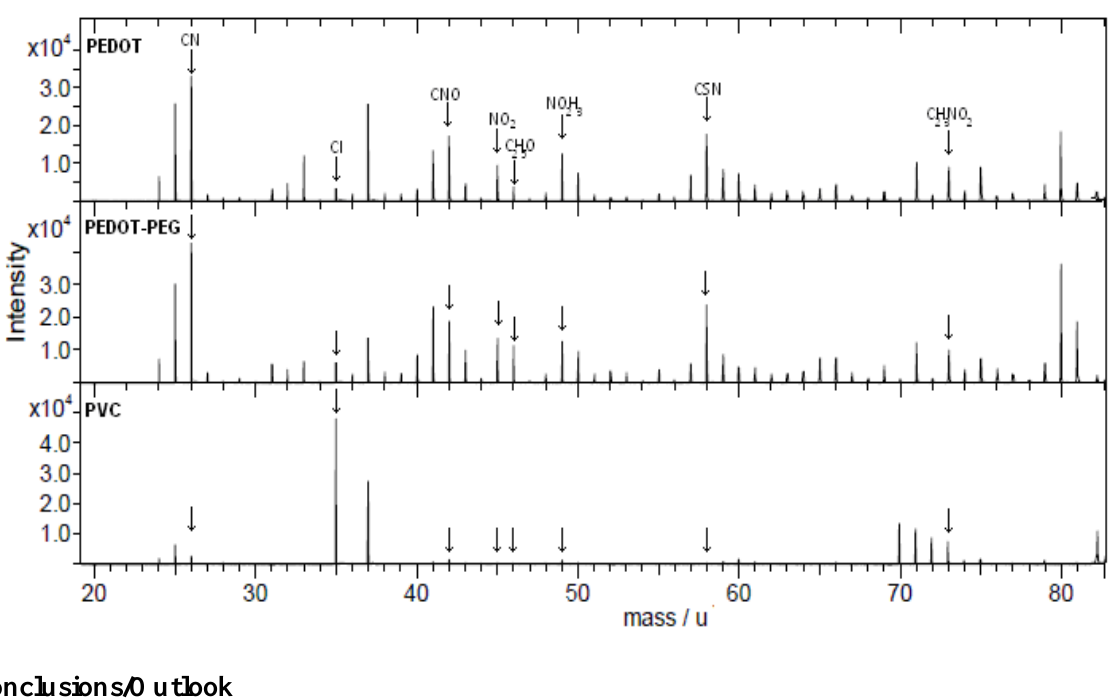
Figure 6. TOF-SIMS relative intensity spectra of the different isotopes on the PVC, PEDOT and PEDOT-PEG